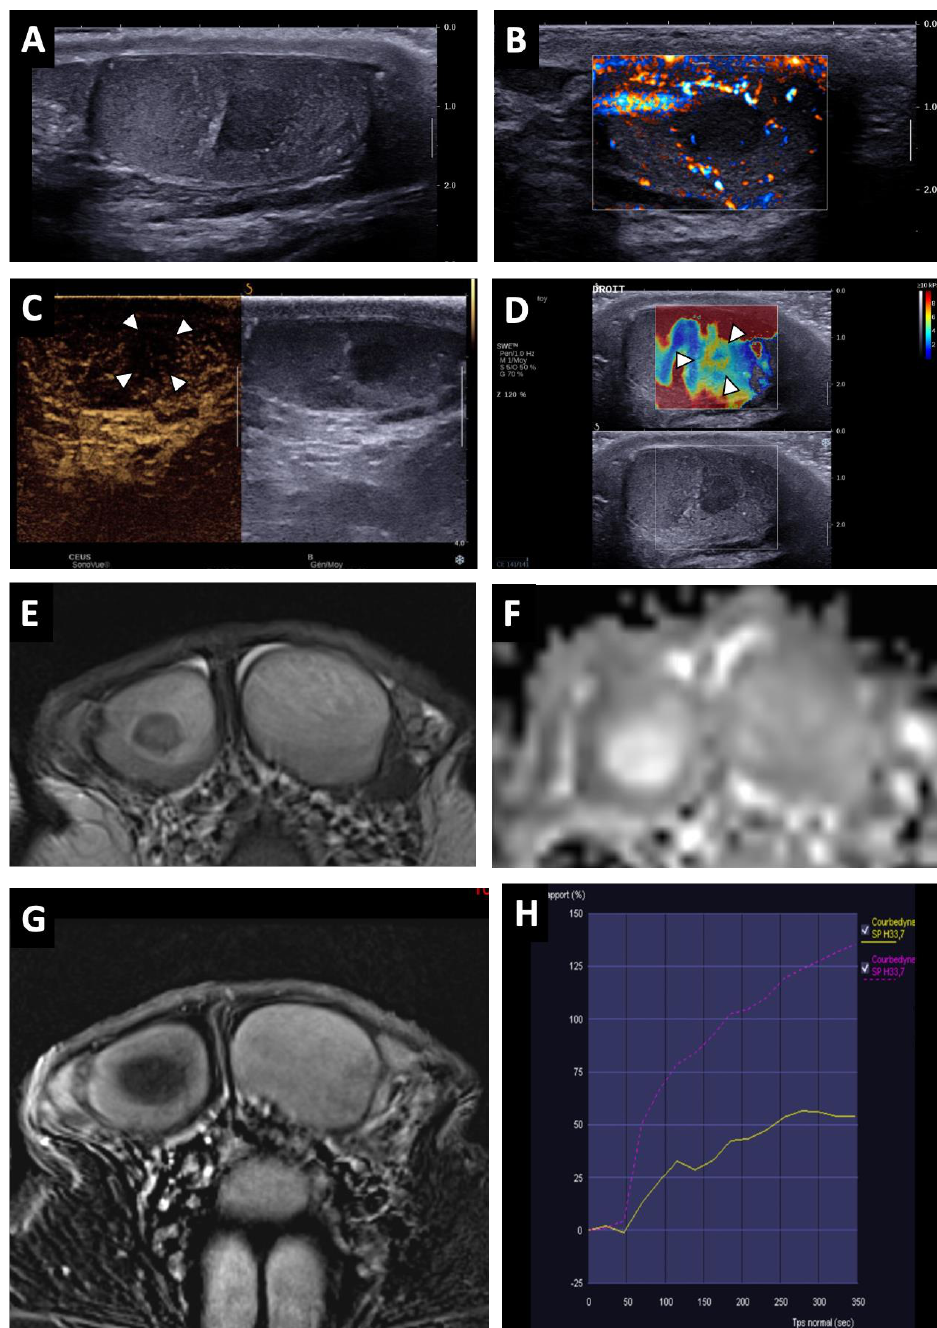
Figure 3. BOTT of the right testis in a 41-year-old man (infertility screening). Transverse B-mode US showed an ill-delineated hypoechoic nodular area ( A ). With colour Doppler US, the hypoechoic nodule was frankly hypovascular upon Ultrasensitive Doppler ( B ). CEUS demonstrated a hypo- enhanced (white arrowheads) area in concordance with the B-mode nodule (note that even the adjacent testis parenchyma was also poorly enhanced) ( C ). SWE map showed an area of increased stiffness in concordance with B-mode nodule ( D ). MRI axial T2W image showing a nodule with a hypo-intense signal (white arrow) ( E ). ADC map of the diffusion sequence demonstrated a focal area with an elevated ADC value compared with the contralateral testis ( F ). After the intravenous injection of gadolinium chelate, an area of reduced enhancement of the nodule was visible ( G ). Nodule enhancement followed the yellow time–signal-intensity curve (type 1) and the contralateral parenchyma corresponded to the purple one ( H